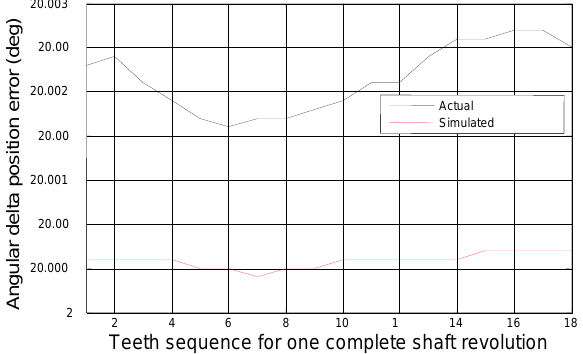
Figure 12. Angular delta shaft position error vector for both simulated and actual systems after